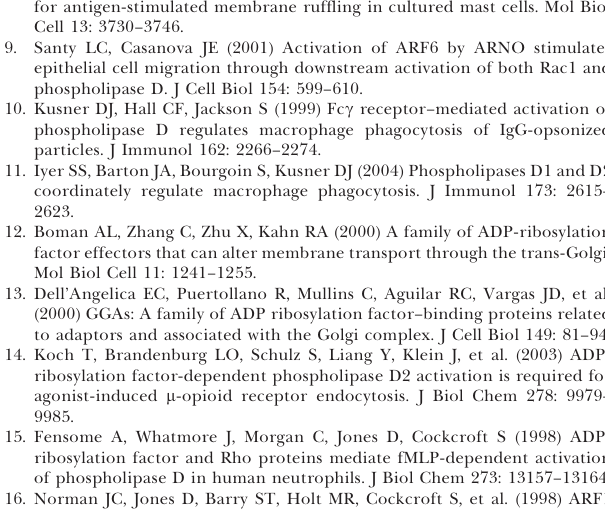
Table S1. Table of E A , E D , E AVG , and R M Values from Cells Expressing the ARF-CFP and YFP-NGAT Molecules Measured for Figure